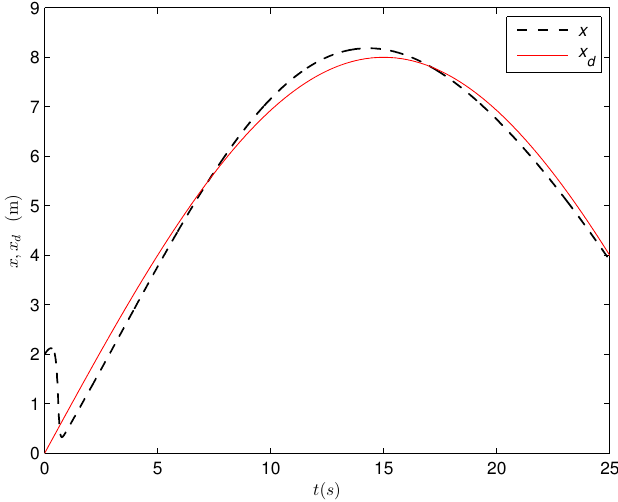
Figure 6. Surge displacement (traditional adaptive